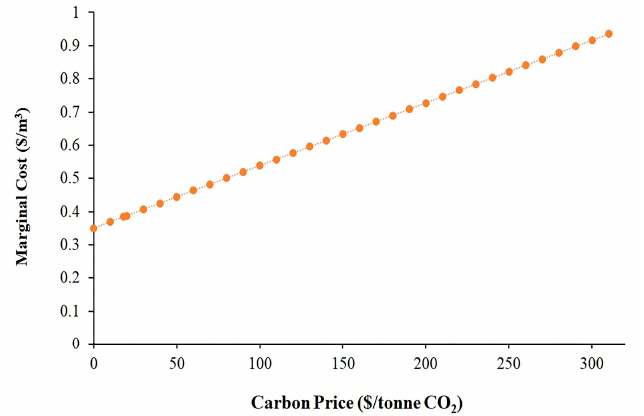
Figure 2. Variation of marginal cost with carbon price.